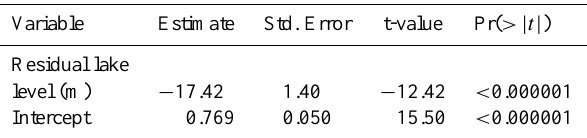
Table 1. Linear regression between the log-transformed CH 4 ef- fluxes from Lake Wohlen and lake level changes as a potential driv- ing variable for